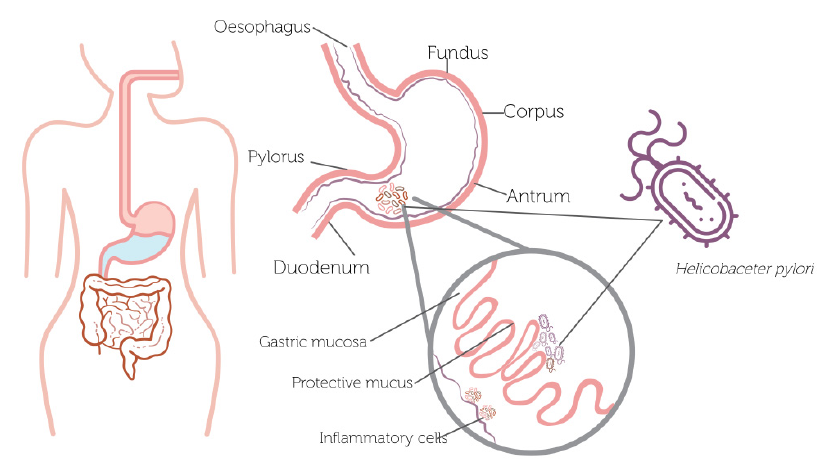
Figure 1. Helicobacter pylori colonization of the human stomach.